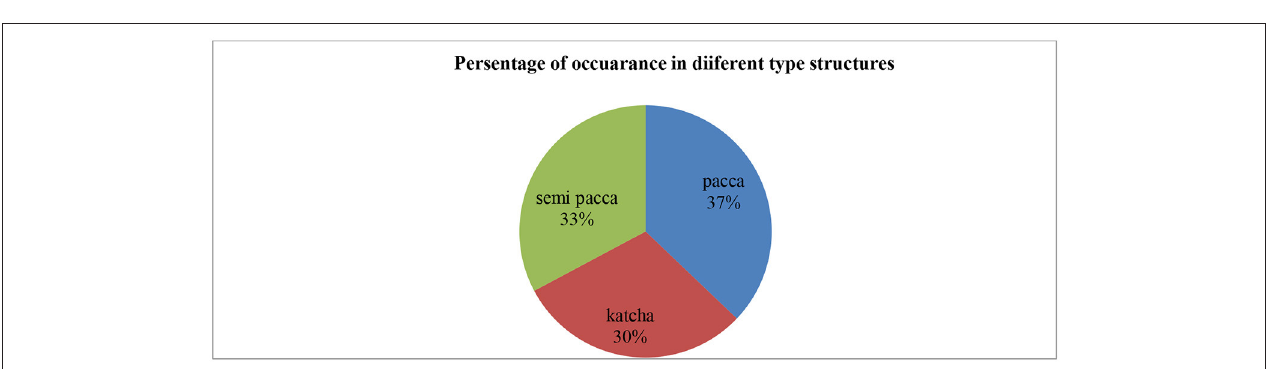
FIGURE 4 | Fire incident trend analysis for different land use types.